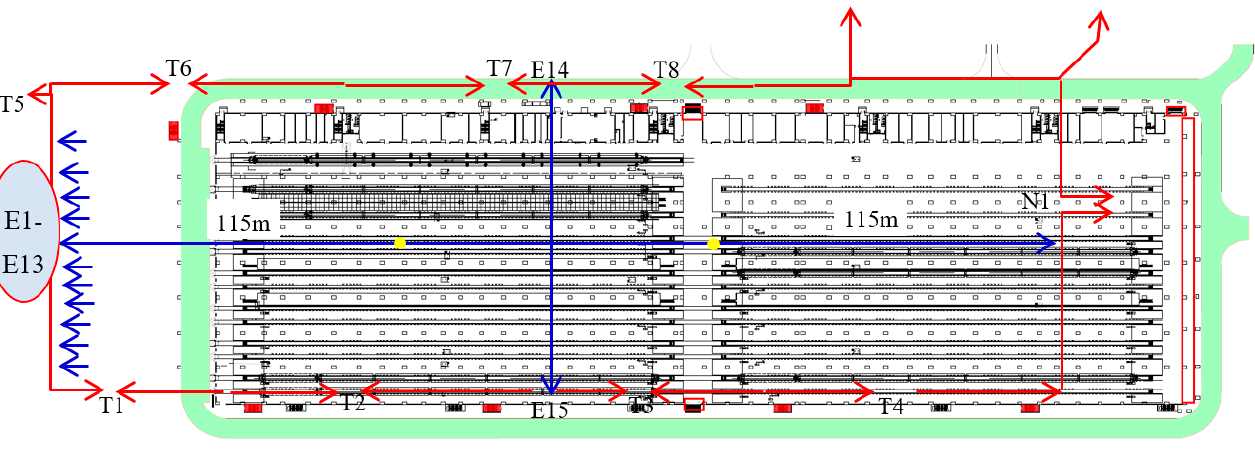
Figure 7. Schematic diagram of the evacuation distance of the application’s library (the longest evacuation distance is 115 m).